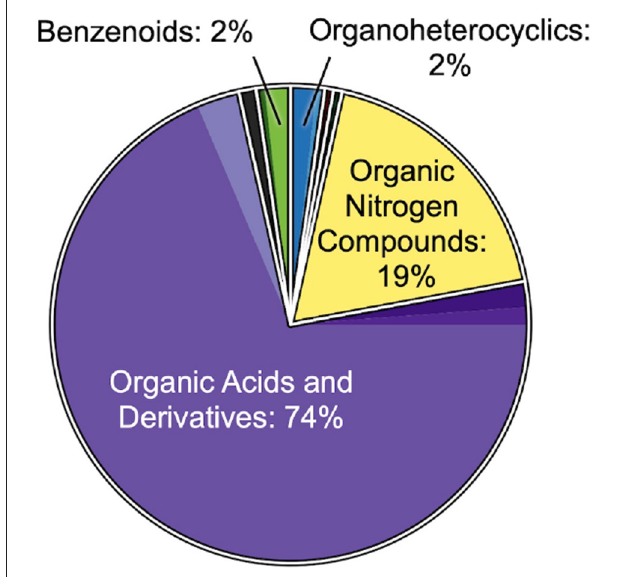
FIGURE 4 | Putative compositions of combined 2018 and 2019 excurrent-depleted features ( n = 108 and 65 features, respectively). Classifications are from CANOPUS ( Dührkop et al., 2020) and based on the ClassyFire nomenclature ( Djoumbou Feunang et al., 2016). The top-level groupings labeled and outlined in white represent superclasses, and the filled color of each superclass is subdivided into shades that correspond to the subclasses listed in Supplementary Figure 4A